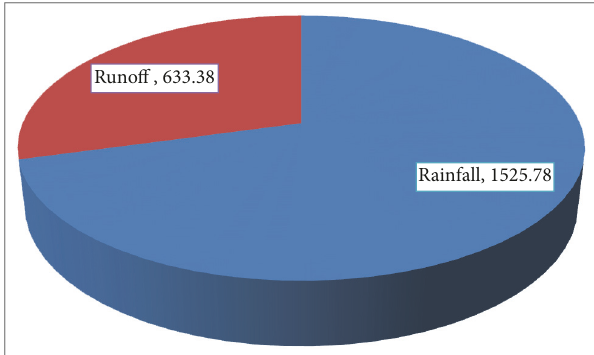
Figure 6: Average annual rainfall and runoff estimated for Ura- pakkam